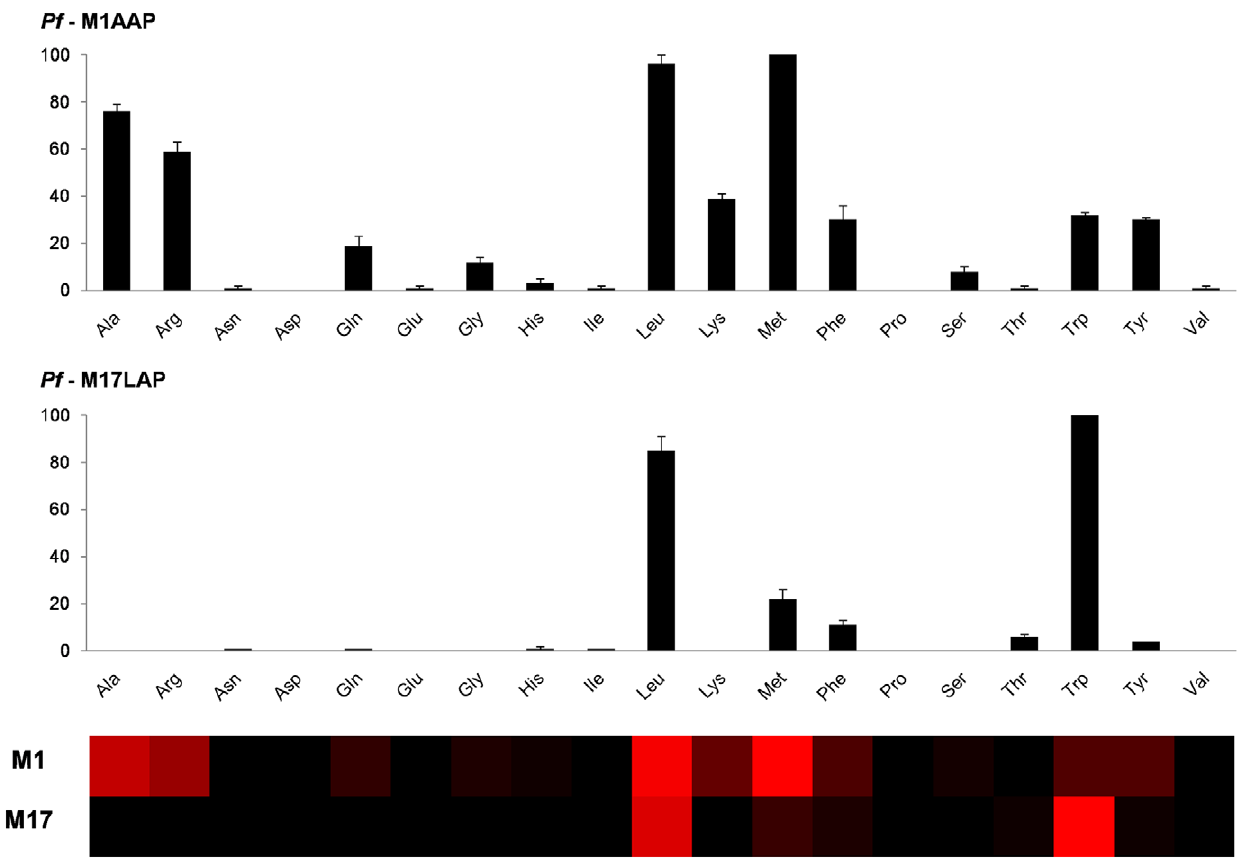
Figure 2. Preferred natural amino acids substrates for recombinant Pf M1AAP and Pf M17LAP. Initial screening of the 19-membered natural amino acid library. Enzyme activity was monitored using an fmax multi-well fluorescence plate reader (Molecular Devices) at excitation wavelength of 355 nm and an emission wavelength of 460 nm. he x-axis represents the abbreviated amino acid names (for full name and structure see Figure S1). The y-axis represents the average relative activity expressed as a percent of the best amino acid. In the heat map view the most preferred positions are displayed in bright red, whereas a complete lack of activity is in black, with intermediate values represented by intermediate shades of red.